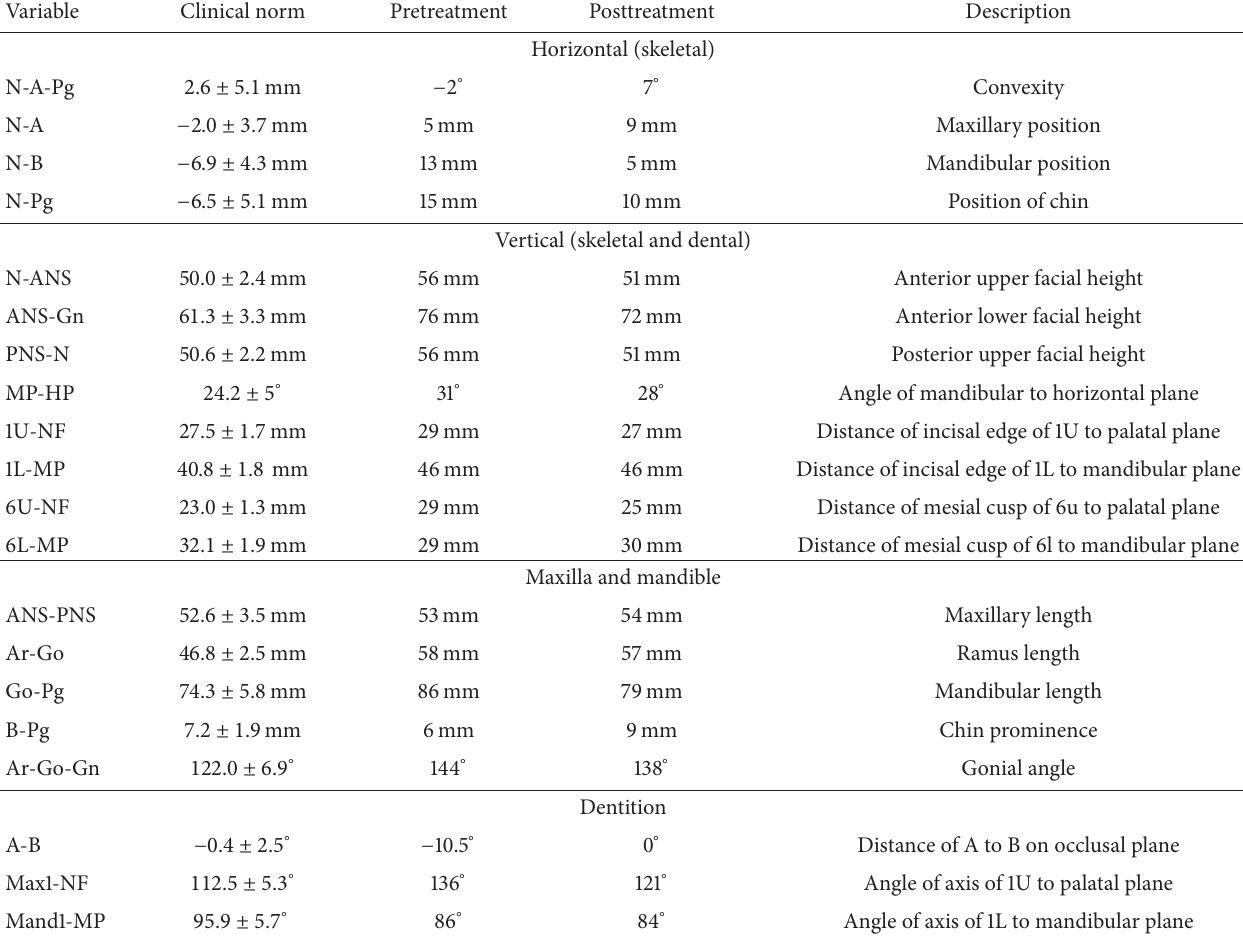
Table 1: Cephalometrics for orthognathic